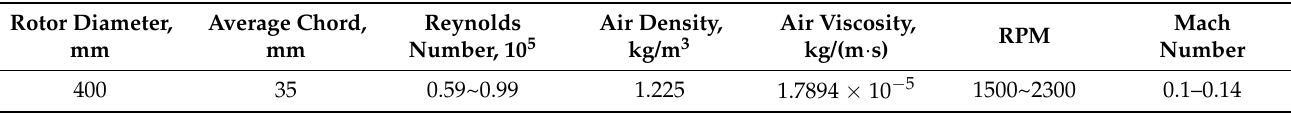
Table 3. Parameters of the propeller. RPM: Revolutions per Minute.